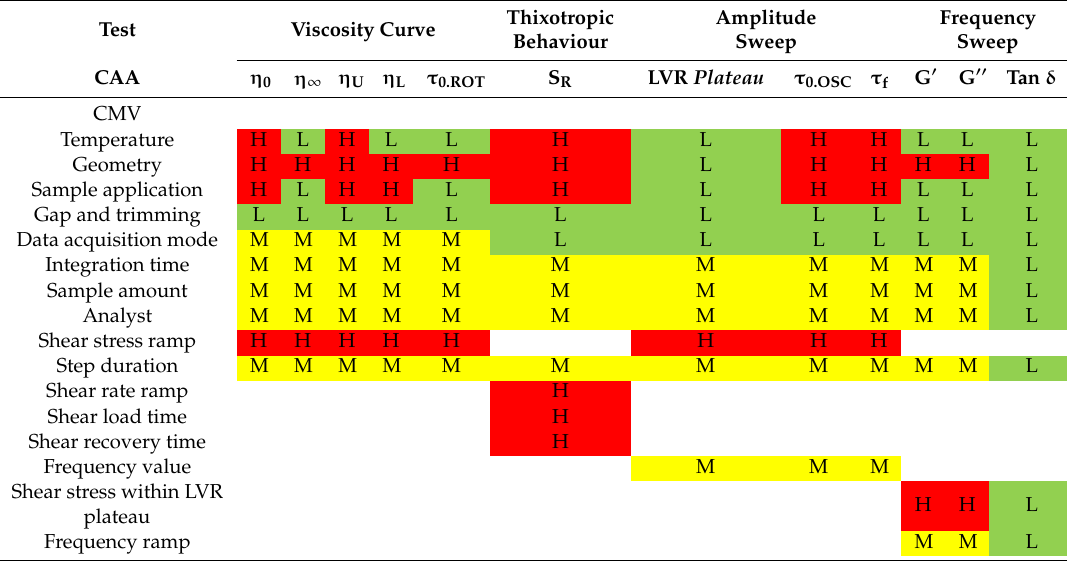
Table 7. Updated risk estimation matrix (REM) for rheology method